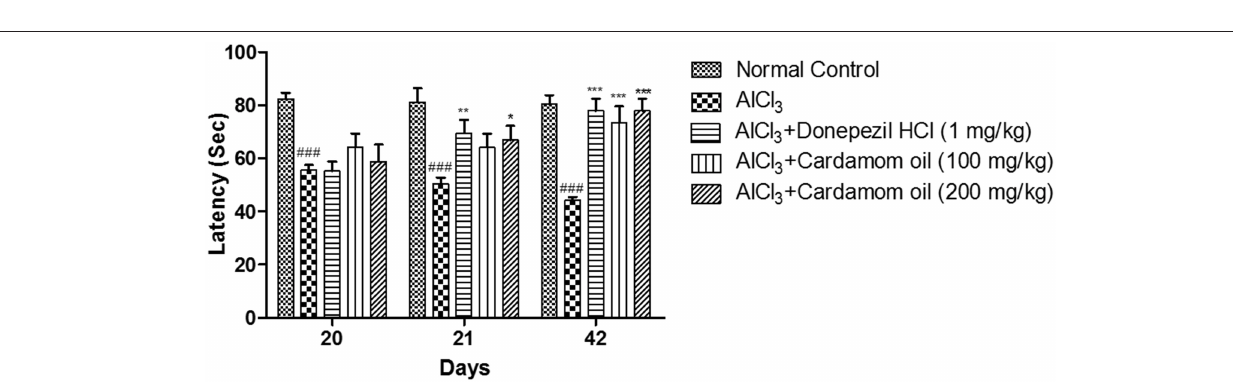
FIGURE 4 | Effect of Cardamom oil on latency of rats using Passive Avoidance test in AlCl 3 -induced neurotoxicity. Data are expressed as mean ± SEM ( n = 6), ### p < 0.001 when compared with normal control, * p < 0.05, ** p < 0.01, *** P < 0.001 when compared with disease control group. AlCl 3 , Aluminum chloride; SEM, Standard Error of Mean. TABLE 2 | Effect of Cardamom oil on brain oxidative stress parameters in hippocampus.